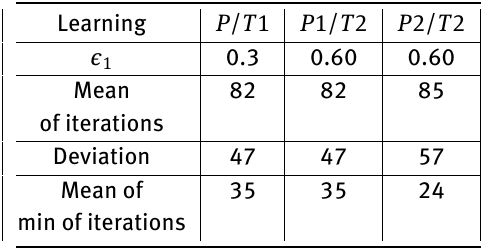
Table 2: Results of testing on 18